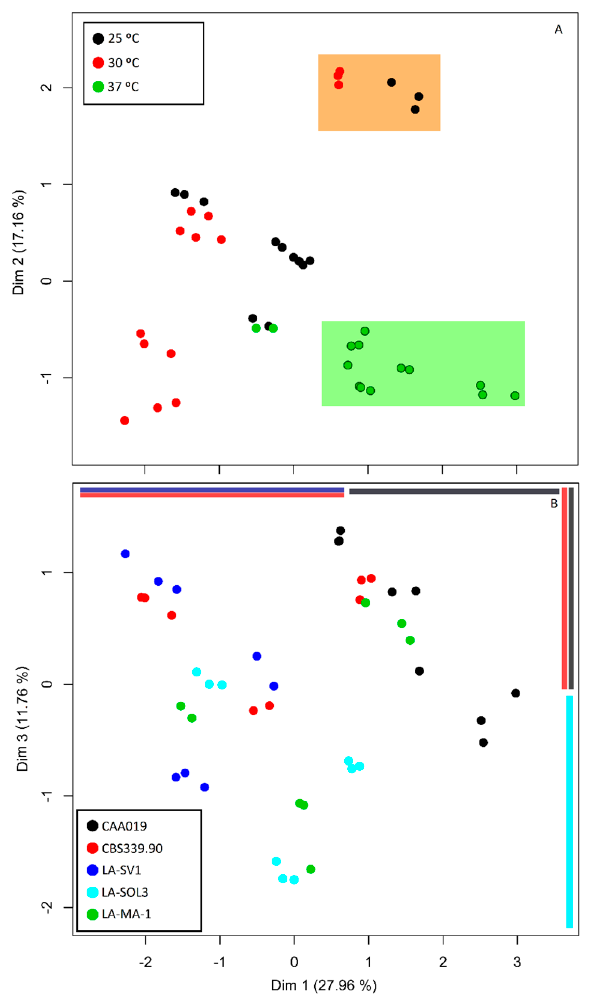
Figure 8. Multi factor analysis of detection, quantification and characterization of extracellular enzymatic activity data at 25 °C, 30 °C and 37 °C L. theobromae strains using the growth temperature ( A ) and the strains ( B ) as factors. Post-hoc analysis of the scores of both dimensions 1 and 3 revealed the one-dimensional separations (colored bars: top–horizontal, right–vertical).